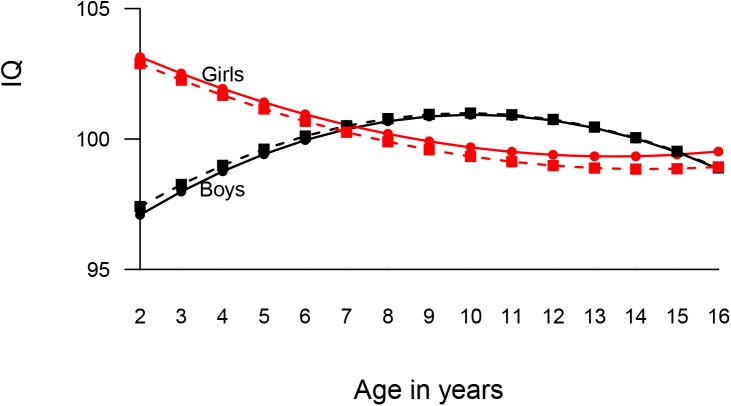
Differences in latent cognitive growth in boys and girls from TEDS from toddlerhood through adolescence.Note: Straight lines represent data from the exploration samples; dotted lines represent data from the replication samples. Boys' trajectories are marked in black; girls' in red.